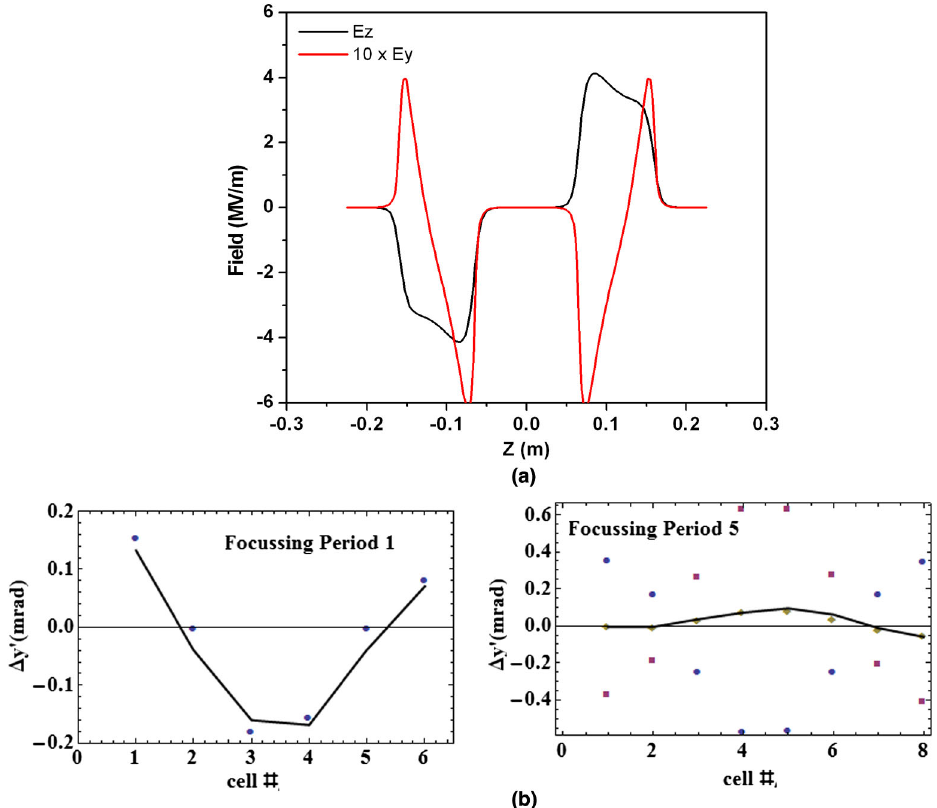
FIG. 11. (a) Electric field for beta ¼ 0 : 15 QWR with tilt angle of 9 (cid:6) . (b) Steering kick calculated using an analytical expression while the black line shows the GPT simulation. Blue dots in period #1 show net steering. In the case of period #5, magenta shows the electric part, blue shows the magnetic part, while yellow dots are net effect.